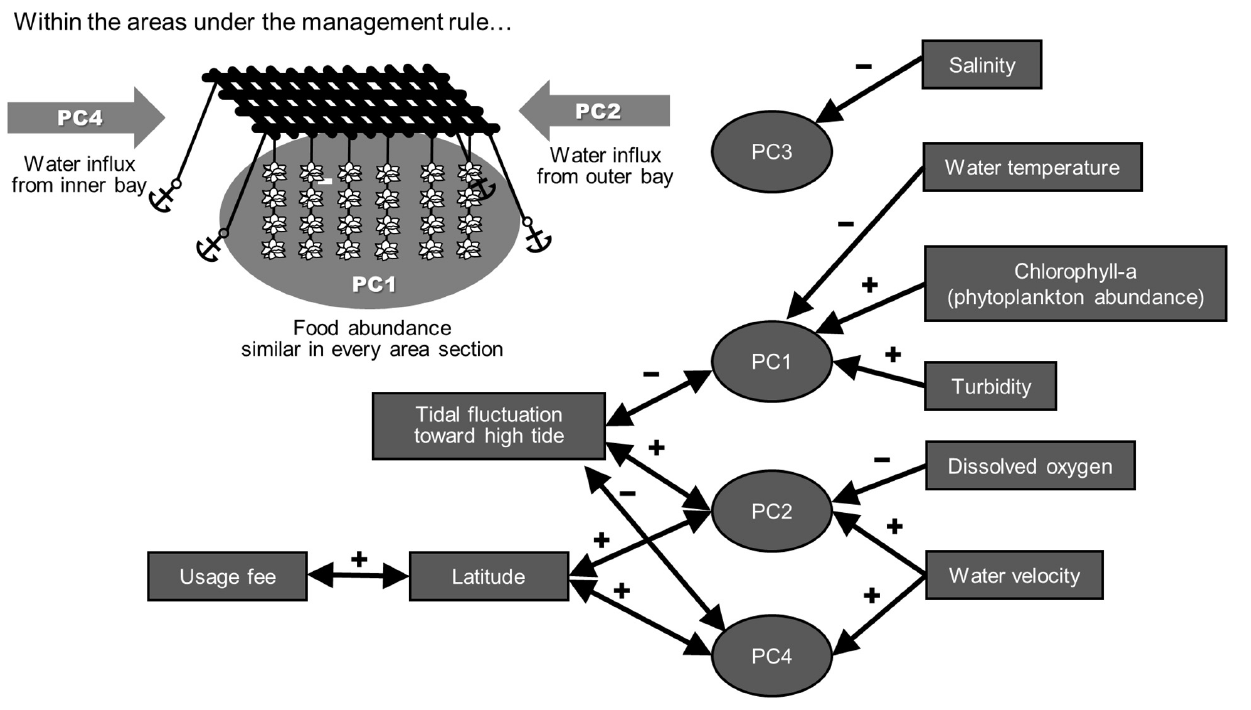
FIGURE 2 | Expected model representing the relationship between the economic values of the individual sections and the environmental characters. Arrows toward both sides indicate correlations obtained with multiple regression analysis using the optimized least squares method. Arrows toward individual principal components (PCs) indicate high correlation between the respective environmental factors and the PC scores. The detailed analytical results are summarized in Tables 1 , 2